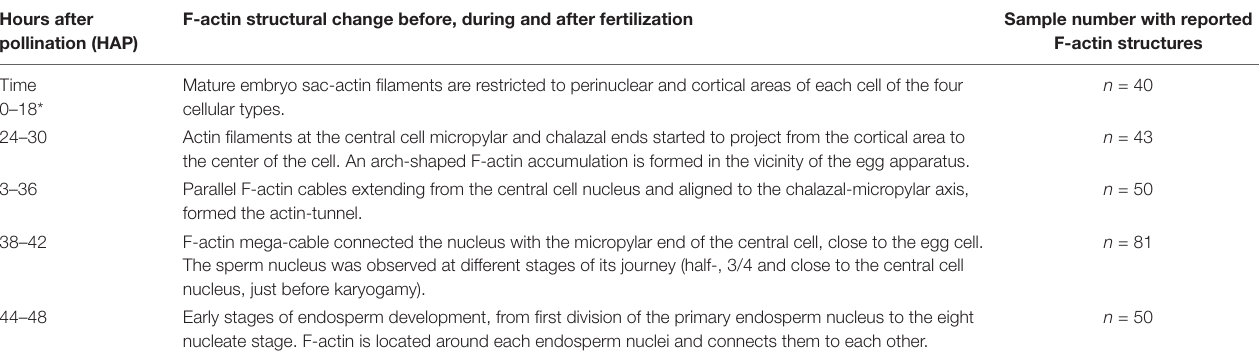
TABLE 1 | Fertilization timing and F-actin dynamics in Agave inaequidens. Hours after F-actin structural change before, during and after fertilization Sample number with reported pollination (HAP)